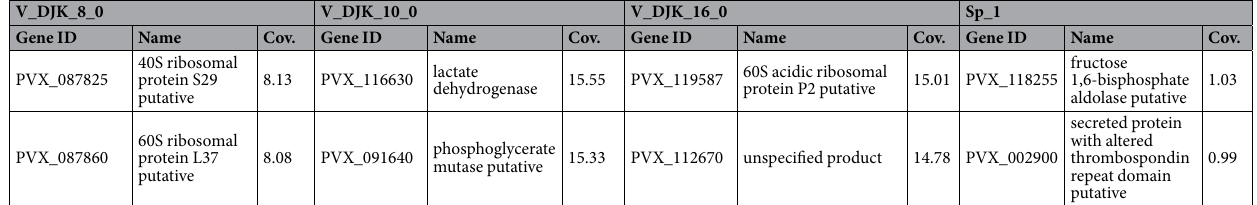
Table 2. List of the 25 most expressed genes in each sample (ranked by their relative coverage in read counts per